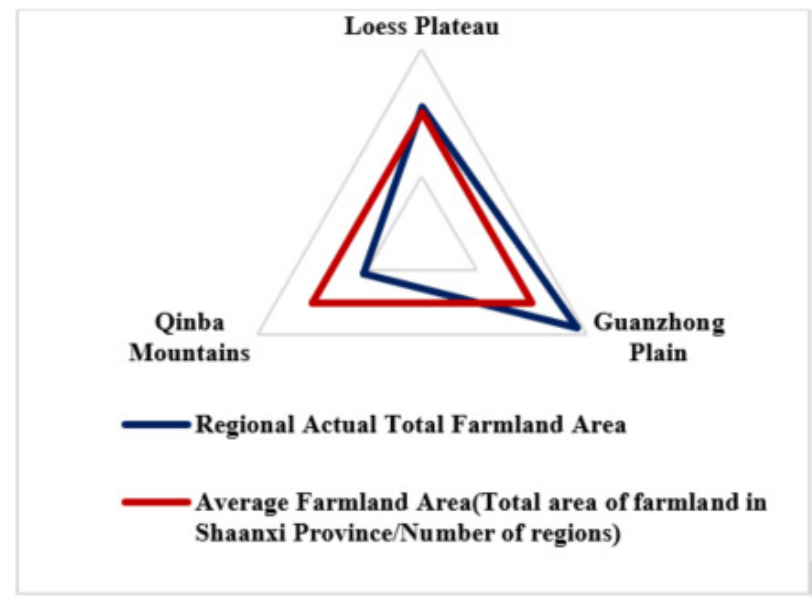
Figure 3. Farmland area of three regions in Shaanxi Province (2018).